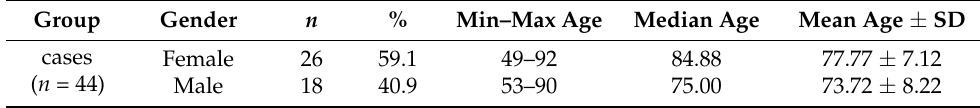
Table 1. Demographic characteristic of the patients’ group enrolled in the